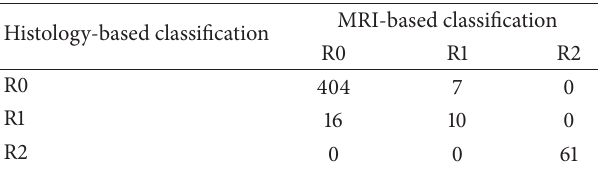
Table 1: Cross tabulation of MRI-based classification by histology- based classification of the 498 measured resection